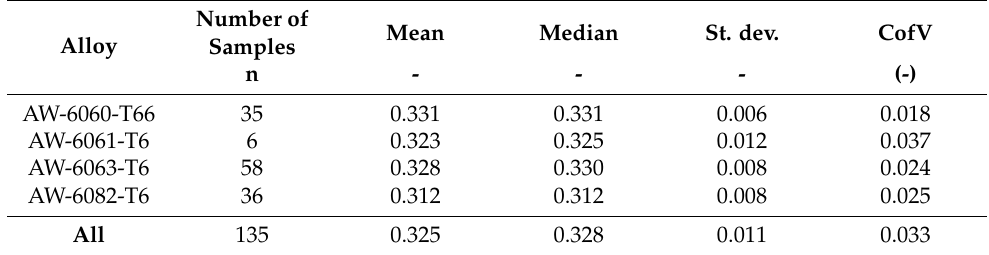
Table 7. Statistical analysis of Poisson’s value.